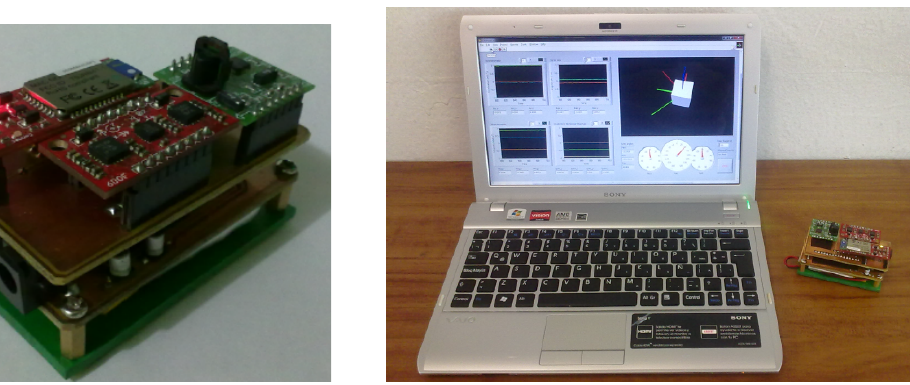
Figure 5. The AHRS prototype.